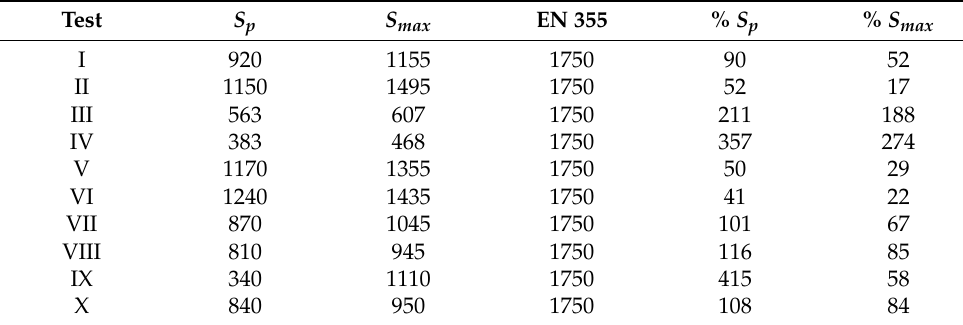
Table 9. Experimental elongation vs. EN 355